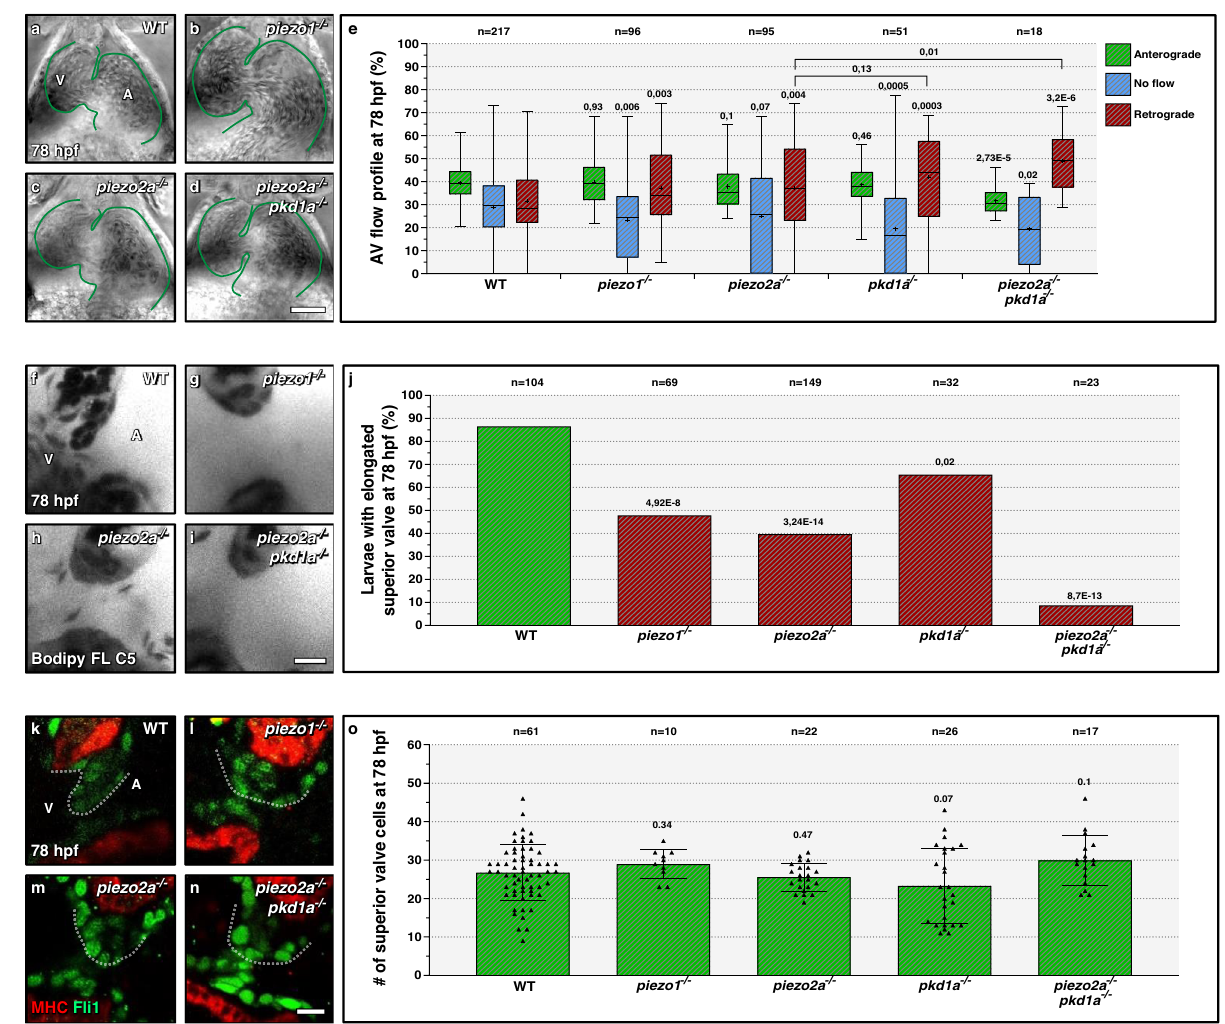
Fig. 3 | piezo1 and piezo2a promote atrioventricular valve development. a – d Bright fi eld images of 78 hpf wild-type ( a ), piezo1 mutant ( b ), piezo2a mutant ( c ),and piezo2a;pkd1a doublemutant ( d ) hearts; one timepoint of a spinning disc movie at atrial diastole; green lines outline the heart. e AV fl ow pro fi le of 78 hpf wild-type, piezo1 mutant, pkd1a mutant, piezo2a mutant,and piezo2a;pkd1a double mutant larvae; average pro fi le of three cardiac cycles per zebra fi sh. f – i Confocal imaging of 78 hpfwild-type( f ), piezo1 mutant ( g ), piezo2a mutant ( h ),and piezo2a; pkd1a double mutant ( i ) hearts stained with Bodipy FL C5-Ceramide; AV canal magni fi ed images. j Superior AV valve elongation of 78 hpf wild types, piezo1 mutants, pkd1a mutants, piezo2a mutants, and piezo2a; pkd1a double mutants. k – n Confocal imaging of 78 hpf wild-type ( k ), piezo1 mutant ( l ), piezo2a mutant ( m ),and piezo2a;pkd1a doublemutant( n )heartsimmunostainedforMHCandFli1;